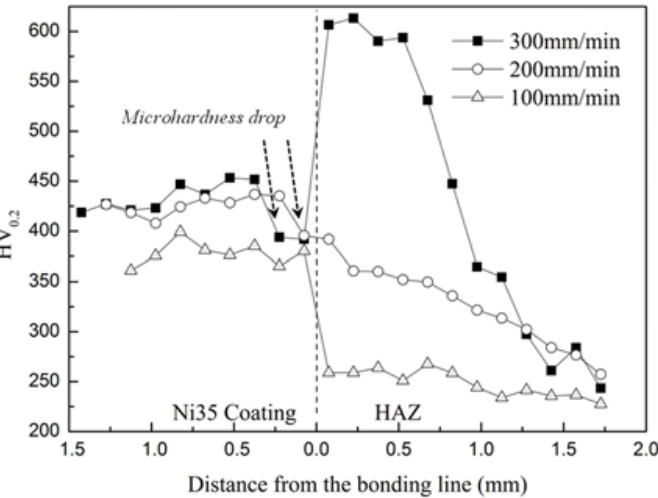
Figure 10. Microhardness distribution of Ni35 coatings fabricated at 5 kW. As indicated by the arrow, a microhardness drop occurred in the bottom region of the coating for Vs of 300 and 200 mm/min. This was because the martensite transformation could result in volume expansion in the HAZ, which caused tensile stress in the adjacent coating bottom. Moreover, microhardness decreased due to the existence of tensile stress. This was absent for Vs of 100 mm/min due to the absence of martensite transformation. The average microhardness values of the Ni35 coatings were shown in Figure 11. It was found that for a given laser power, microhardness increased gradually with the increase in Vs from 100 mm/min to 300 mm/min. This was ascribed to the finer microstructure at